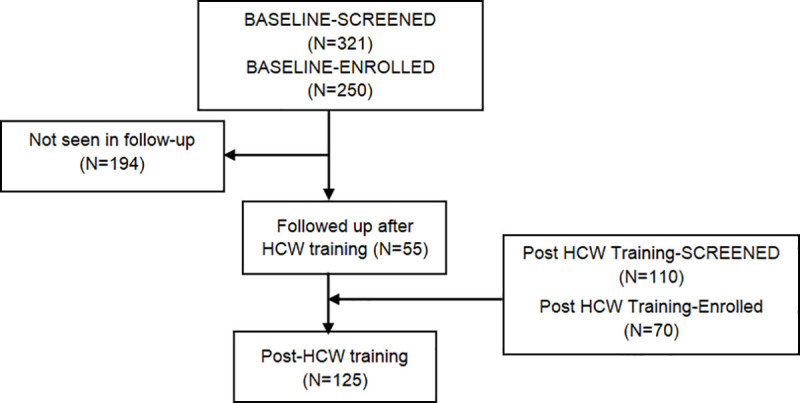
Participant flow.